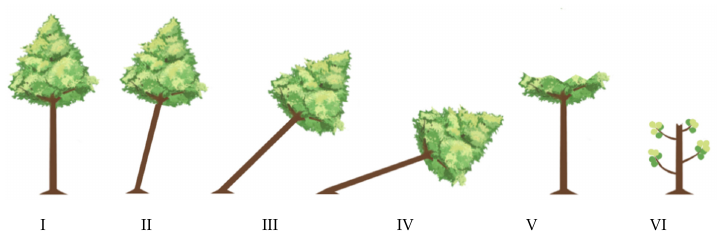
Figure 3. Classification criteria on degree of stem inclination and silhouettes of tree stems. Eight indicators of nonspatial structure were assigned: preservation rate, stand den- sity, height, diameter, stem form, degree of stem inclination, tree-species composition, and age structure. The preservation rate means the percentage of tree survival after a period of afforestation, which indicates the degree to which trees are kept safe from damage of external disturbance. The calculation formula is as follows: